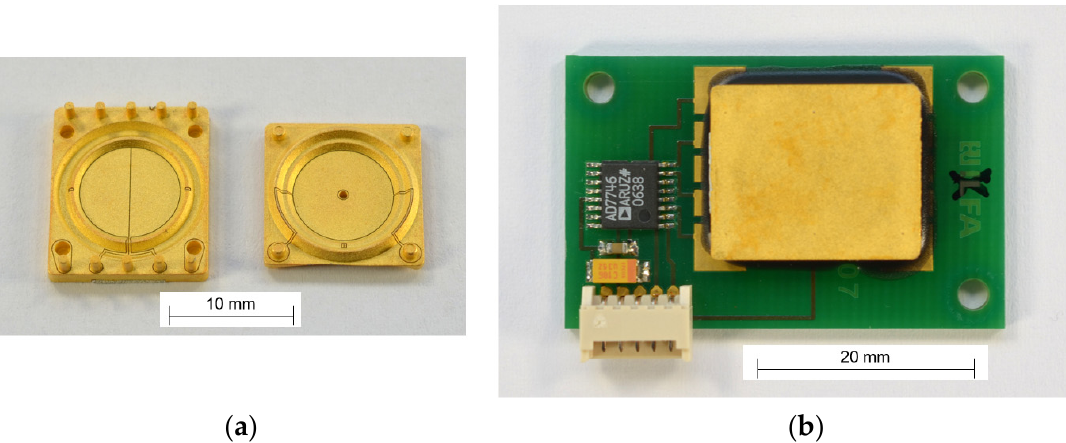
Figure 15. MID version of the fluidic capacitive inclination sensor: ( a ) Components of the sensor element; ( b ) Sensor element with electronics on PCB.